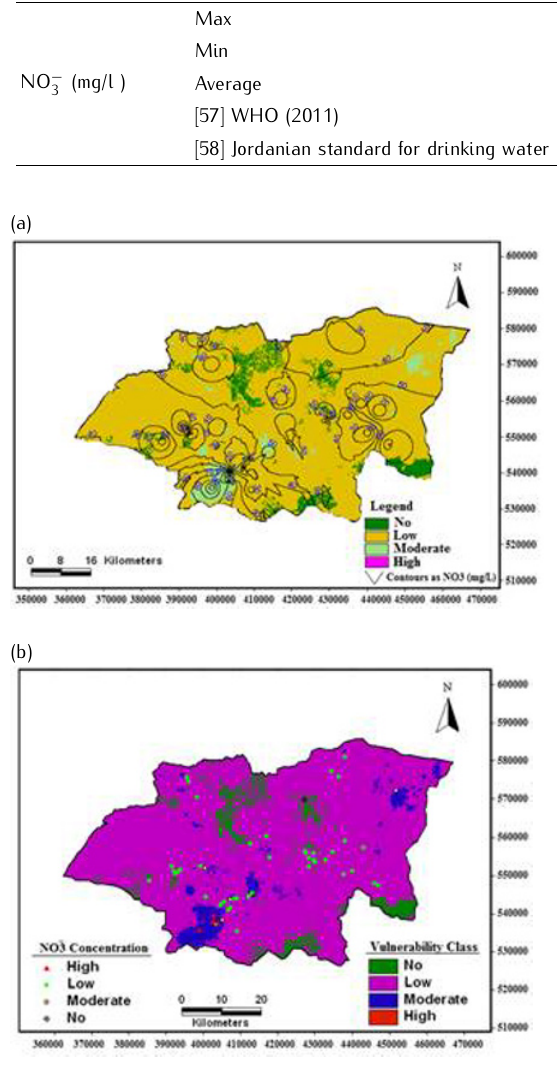
Figure 16. (a) Relationship map of NO − 3 concentration with the risk mapintheAZB;(b)LocationsofsampleswithhighNO-3 concentration on the vulnerability class’s